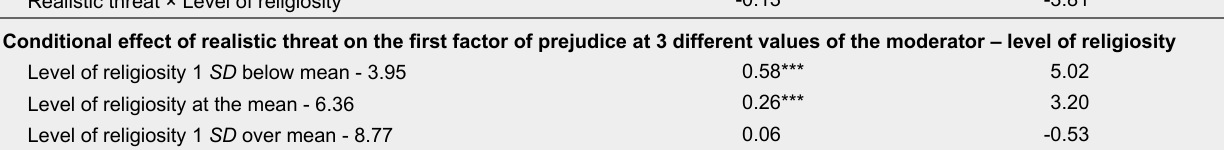
b Coefficients for the Model 1: Realistic Threat and Religiosity on the First Factor of Prejudice Effect b t Main and interaction effects of predictor variables Realistic threat Level of religiosity Realistic threat × Level of religiosity -3.81 Conditional effect of realistic threat on the first factor of prejudice at 3 different values of the moderator – level of religiosity Level of religiosity 1 SD below mean - 3.95 Level of religiosity at the mean - 6.36 Level of religiosity 1 SD over mean - 8.77